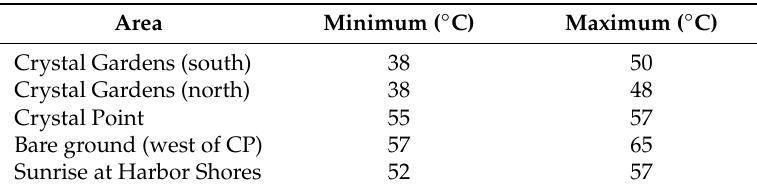
Table 1. Daytime surface temperatures.